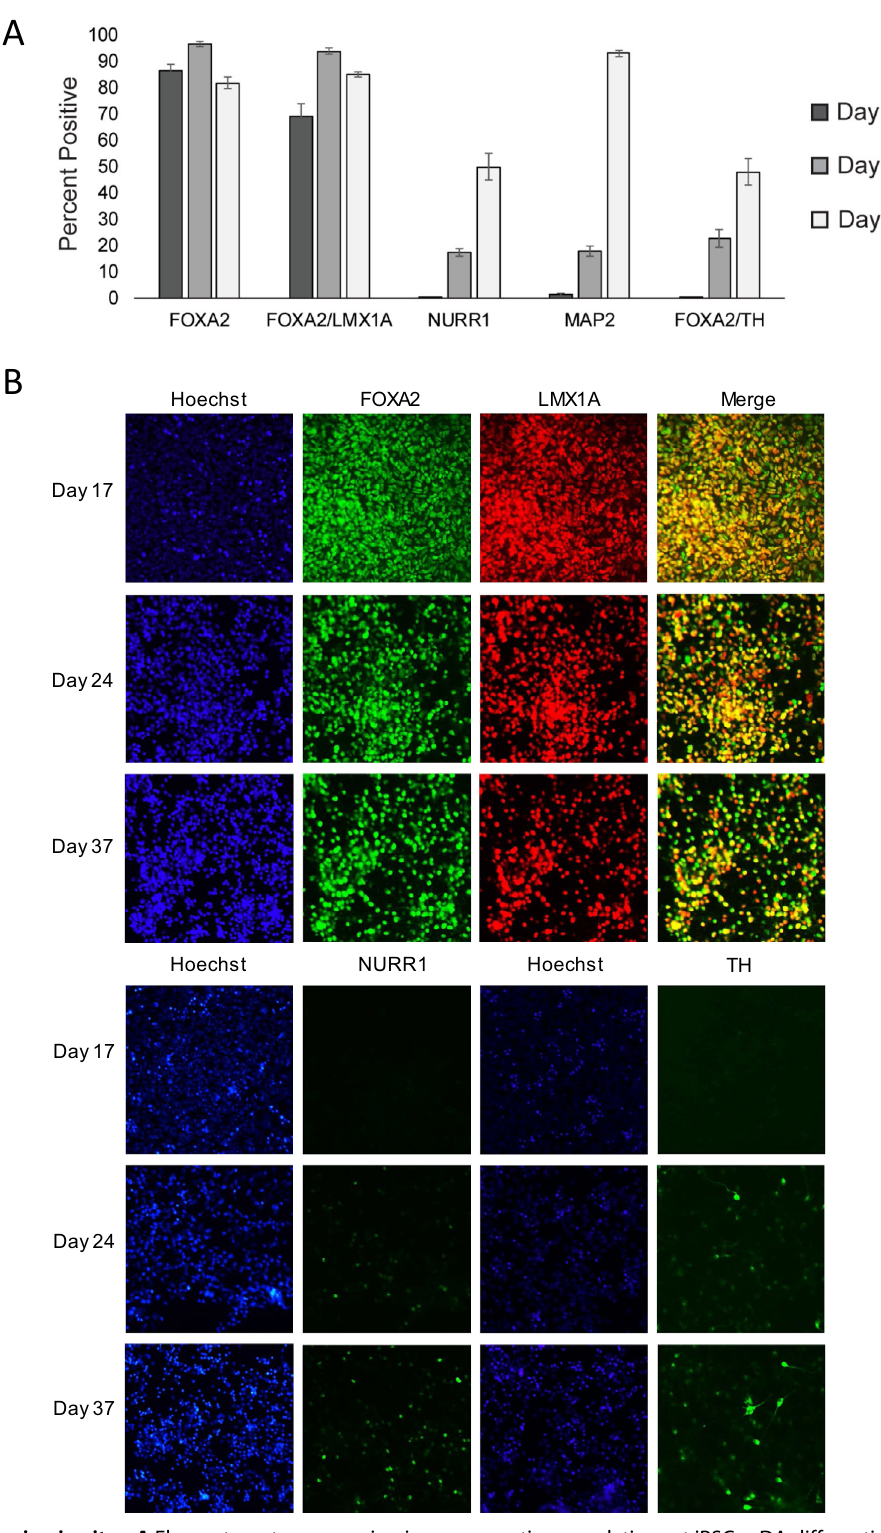
Fig. 2 Protein expression in vitro. A Flow cytometry comparing immunoreactive populations at iPSC-mDA differentiation Days 17, 24, and 37 of mDA target markers. Quanti fi cation of positive cell populations of live cells shown for FOXA2 + , FOXA2 + /LMX1 + , NURR1 + , MAP2 + , and FOXA2 + /TH + . Three biological replicates were analyzed for each time point (Mean ± SEM). B Immunocytochemistry comparing immunoreactive populations at iPSC-mDA differentiation Days 17, 24, and 37 of mDA target and off-target markers. Images are representative of three biological replicates analyzed for each time